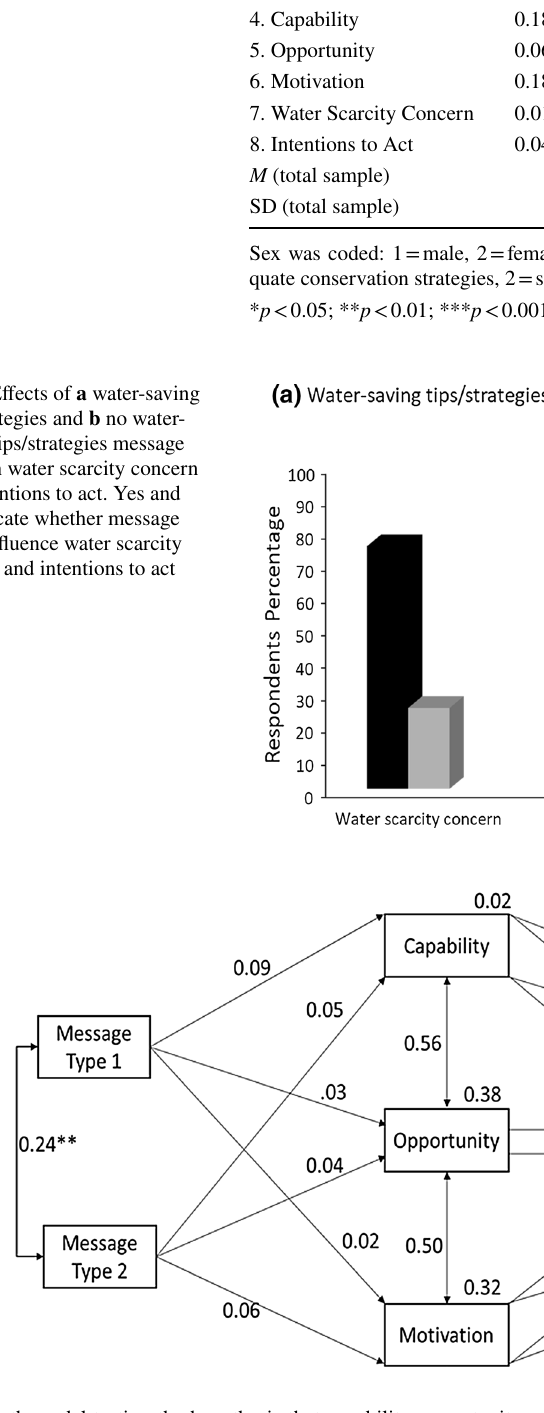
Fig. 2 Path model testing the hypothesis that capability, opportunity, and motivation dimensions mediate the effect of water-conservation message types (1 = severe water scarcity—water-saving tips/strategies and 2 = severe water scarcity—no water-saving tips/strategies) and